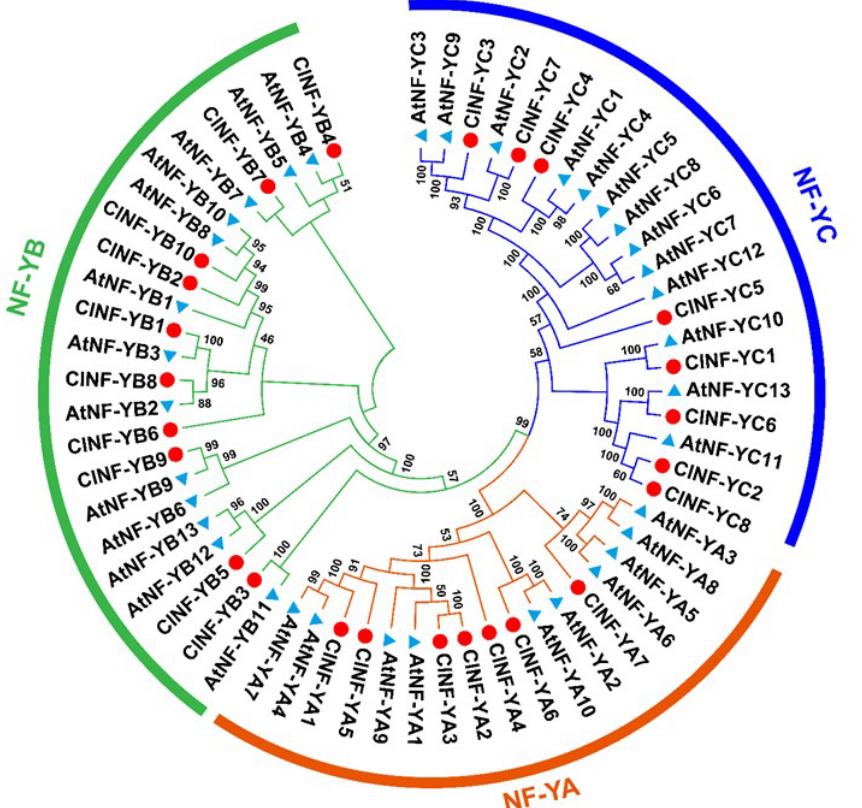
Figure 1. Phylogenetic relationships of the watermelon ClNF-Y proteins with Arabidopsis AtNF-Y proteins. The phylogenetic tree was constructed via Clustal X1.8 and MEGA 7.0 software using the neighbor-joining method with 1000 bootstrap replicates. The red circles and blue triangles represent the ClNF-Y and AtNF-Y proteins, respectively.